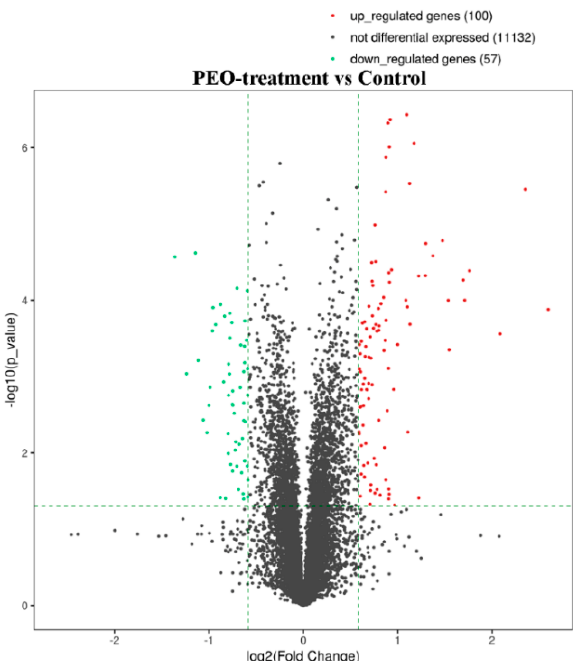
Figure 7. The volcano plot of mRNA. The vertical two green lines were up-regulated (right side) and down-regulated (left side), respectively. The green parallel lines corresponded to the p-value threshold. Green dots represent down-regulated genes with significant differences, red dots represent up-regulated genes with significant differences, and gray dots represent non-significant different genes.